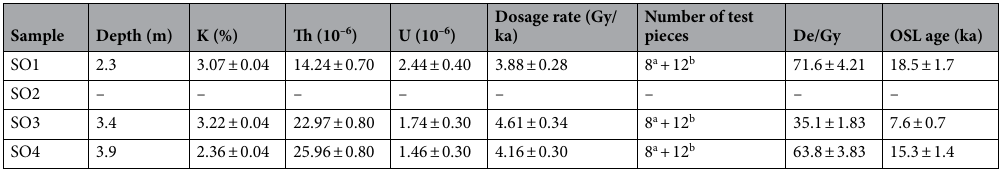
Table 2. Sample dose rate and Optically Stimulated Luminescence dating results for the Shuangyu slackwater deposit. a Number of test pieces using the Single Aliquot Regenerative-dose method. b Number of test pieces using the Standardized Growth Curve